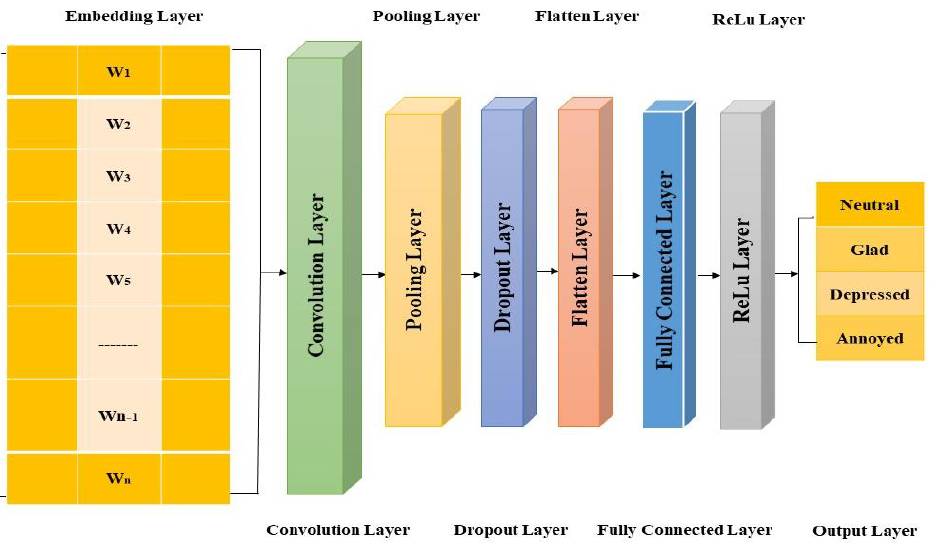
Figure 2. Text-Based Sentimental Classification through Single Layer Convolutional Neural Net- work.